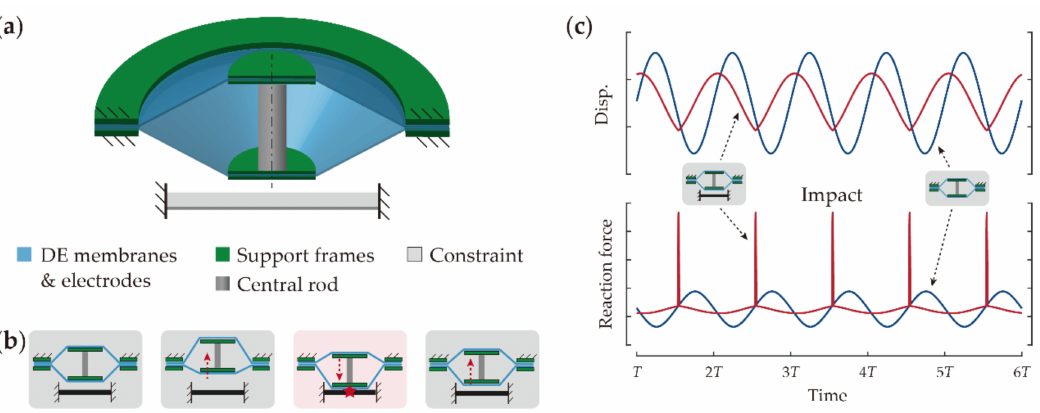
Figure 1. ( a ) Schematic diagram of the resonant-impact DEA system. ( b ) Motion of the resonant- impact DEA system in one typical impact oscillation cycle. ( c ) Displacement of the moving mass and the reaction force on the supporting rig. Red curves: proposed resonant-impact DEA system; blue curves: identical DEA without the impact